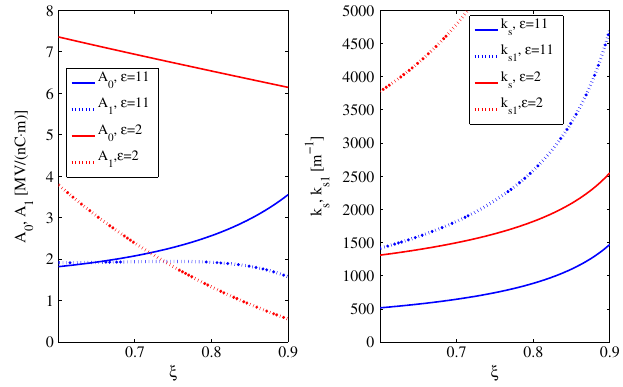
=r ¼ for r 1 2 2